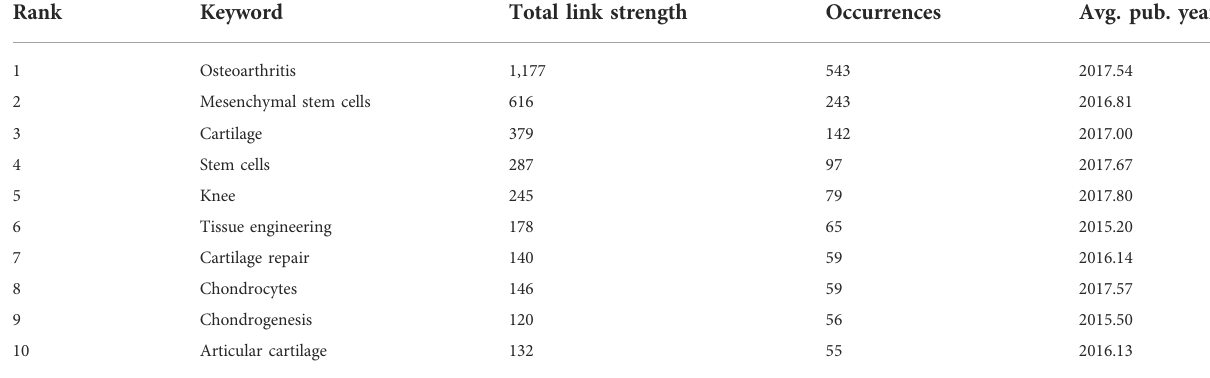
TABLE 3 Top 10 keywords by frequency from the included publications on stem cell research for KOA ( n =